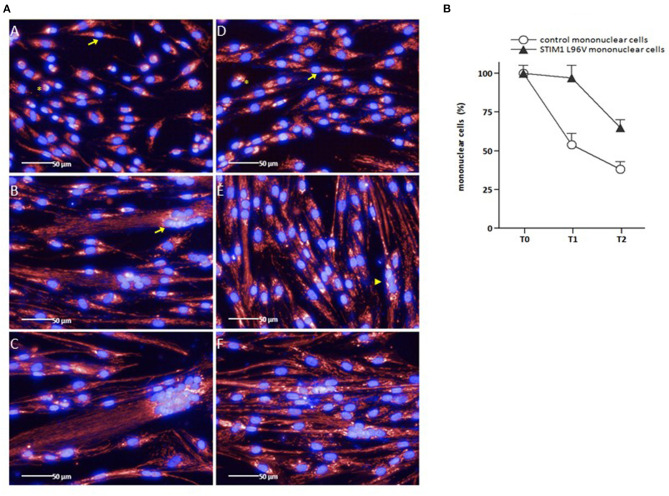
Representative images of control and STIM1 L96V skeletal muscle cells at different time points in differentiation medium (A), and differentiation-associated decrease of control and STIM1 L96V mononuclear cells (B). (A) Control and STIM1 L96V mononuclear mononuclear cells were seeded in 96-well cell culture plates (6,000/100 μL). Upon reaching sub-confluence (~60%), growth medium was replaced by differentiation medium to induce myoblast differentiation and myotube formation. For fluorescence staining of mitochondria (red) and nuclei (blue), MitoTracker Deep Red and Hoechst 33,342 were added into the media (final concentration 50 nM and 1 μM, respectively). After 30 min of incubation at 37°C, 5% CO2, live-cell images were recorded by automated fluorescence microscopy at day 0 (T0), 5 (T1), and 10 (T2) for control (panels A, B, C) and STIM1 L96V cells (panels D, E, F), respectively (Perkin Elmer Operetta High-Content Imaging System, 40x LWD objective). Asterisks and arrows in panels A and D indicate rounded and spindle-shaped control and STIM1 L96V myoblasts at T0, respectively. The arrow and arrowhead in panels B and E indicate a multinucleated control and STIM1 L96V cell at T1, respectively. (B) The percentage of mononuclear control and STIM1 L96V cells at distinct time points in differentiation medium is shown as mean ± SD.